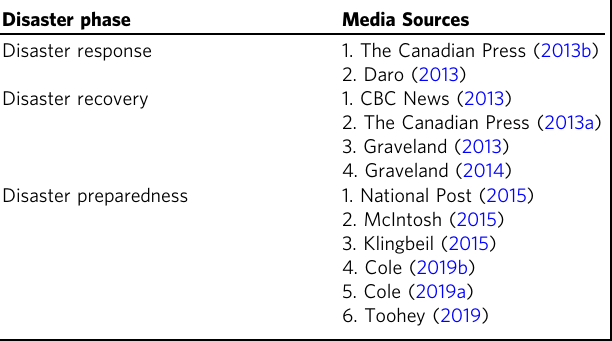
Table 1 Media sources by disaster